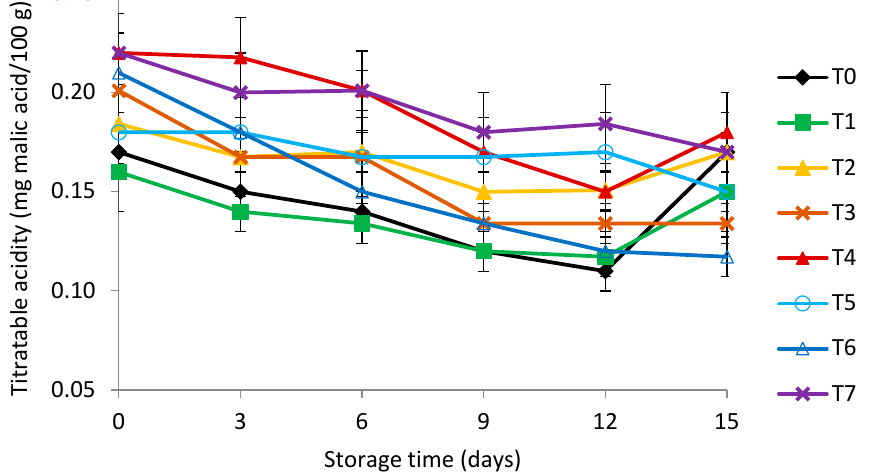
Figure 5. Titratable acidity of control and treated fresh-cut pears stored for 15 days at 8 ± 1 °C. T0—Control; T1—0.2% PE + 1% CaCl 2 ; T2—0.2% PE + 1% CaCl 2 + 0.2% PS; T3—0.2% PE + 1% CaCl 2 + 0.2% PS + 1% N -AC; T4—0.2% PE + 1% CaCl 2 + 0.2% PS + 1% CA + 1% AA; T5—0.2% PE + 1% CaCl 2 + 0.2% SB; T6—0.2% PE + 1% CaCl 2 + 0.2% SB + 1% N -AC; T7—0.2% PE + 1% CaCl 2 + 0.2% SB + 1% CA + 1% AA. Values are the mean of 6 measurements (3 experiments × 2 replicates). Error bars represent ± SD.